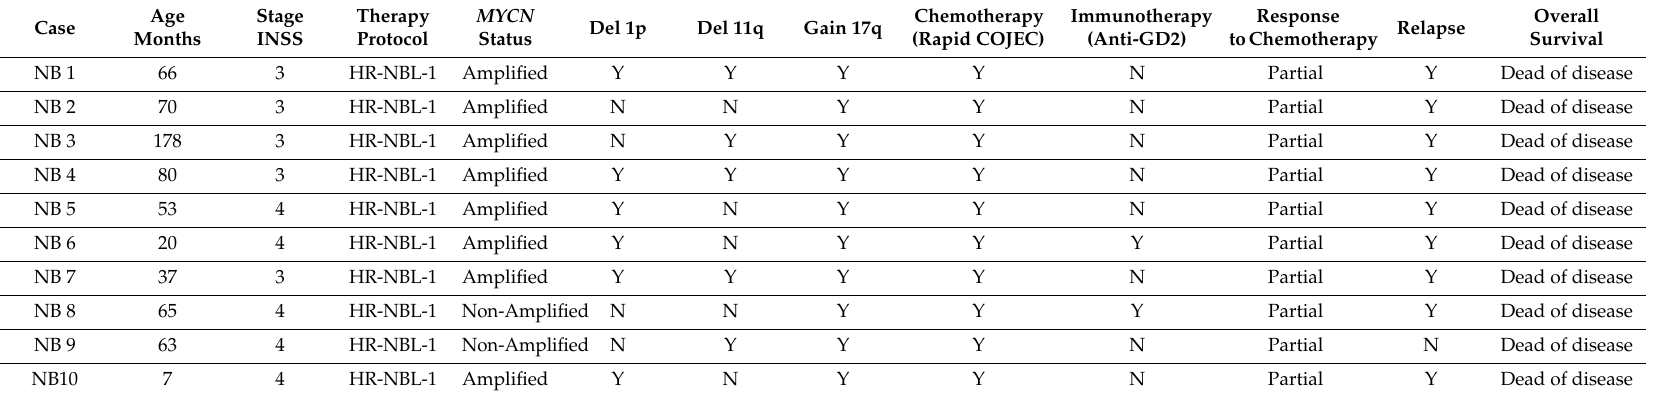
Table 1. Clinicopathological characteristics of Neuroblastoma (NB) patients and post-chemotherapy tumor samples